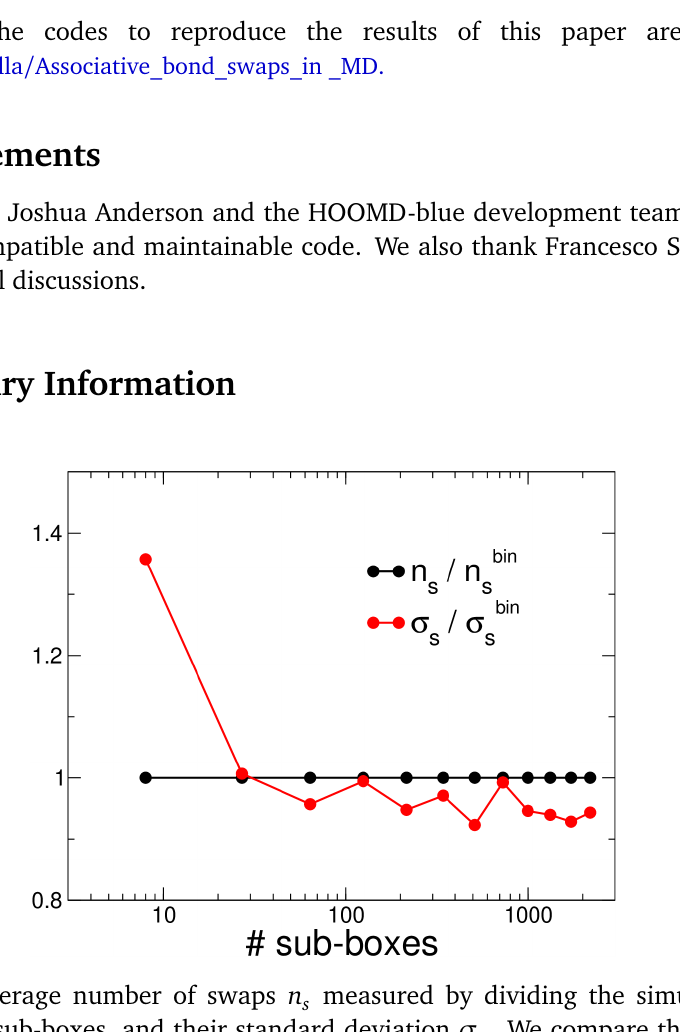
measured by dividing the simulations of s . We compare the numbers s